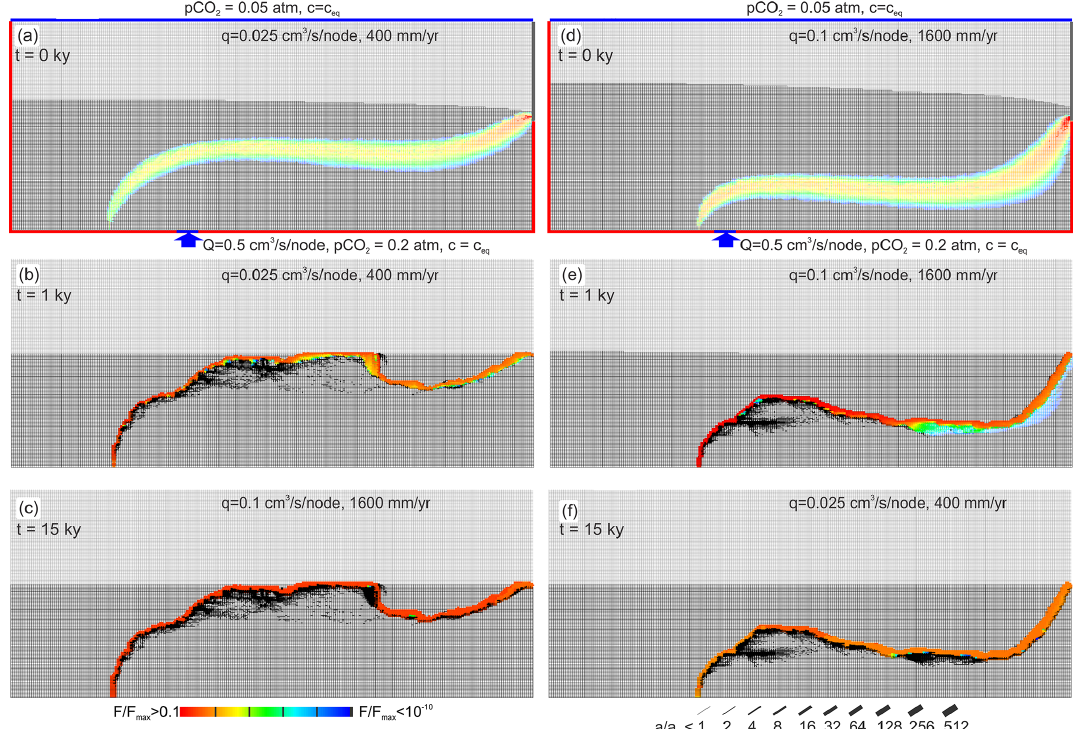
Figure 8. Temporal evolutions when meteoric recharge changes in time. (a–c) Initial input is 400mmyr − 1 and stays constant for 10000 years, and then it switches to 1600mmyr − 1 constant in time. (d–f) Initial input is 1600 mmyr − 1 and stays constant for 10000 years, and then it switches to 400mmyr − 1 constant in